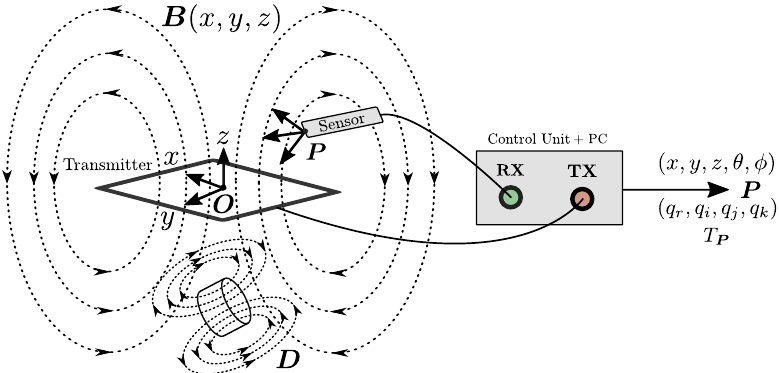
Figure 1. Generalised operation of an EM tracking system. A control unit is connected to a transmitter board (TX) and magnetic sensor (RX). The sensor experiences an induced voltage from the transmitter’s time-varying magnetic field B . The control unit measures this voltage and resolves the sensor position based on this measurement to yield the position and orientation of the sensor P with respect the origin O . The orientation component takes the form of a vector, quaternion or transformation. Distorters D in the region of the TX board distort the magnetic field and result in sensor positioning